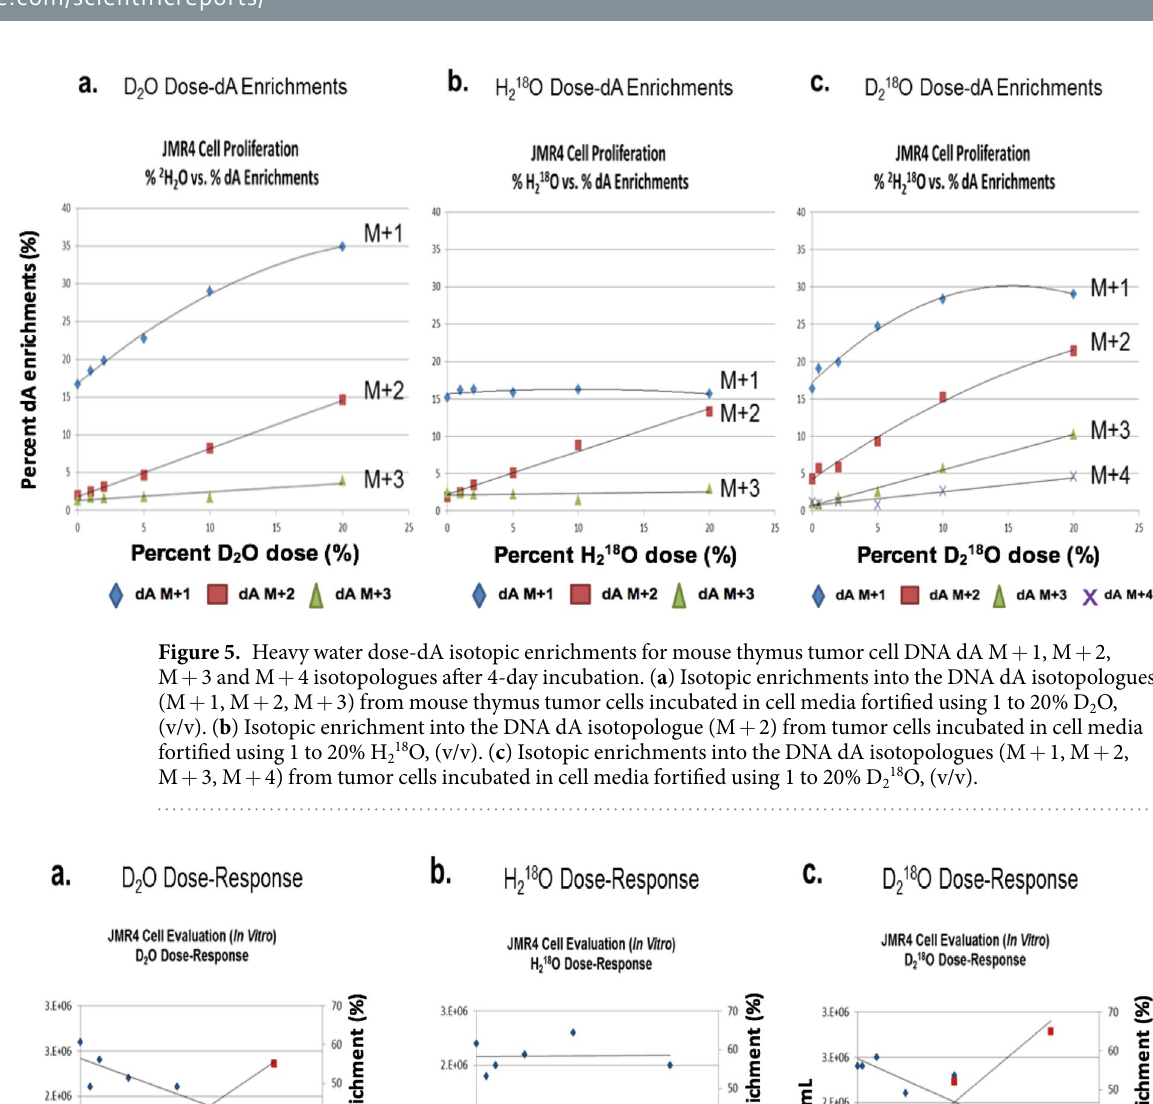
of stable heavy water had an inverse relationship between total isotopic enrichments into the dA isotopologues (summation of dA M + 1 to dA M + 4) versus cell count and viability (live cells/mL) with a decrease in cell pro- liferation of ~40% (Fig. 6a and c). The dose-response results for H 218 O water revealed it had less total isotopic enrichments into the dA isotopologues (summation of dA M + 1 to dA M + 4) with no significant effect on cell count and viability (live cells/mL) (Fig. 6b).